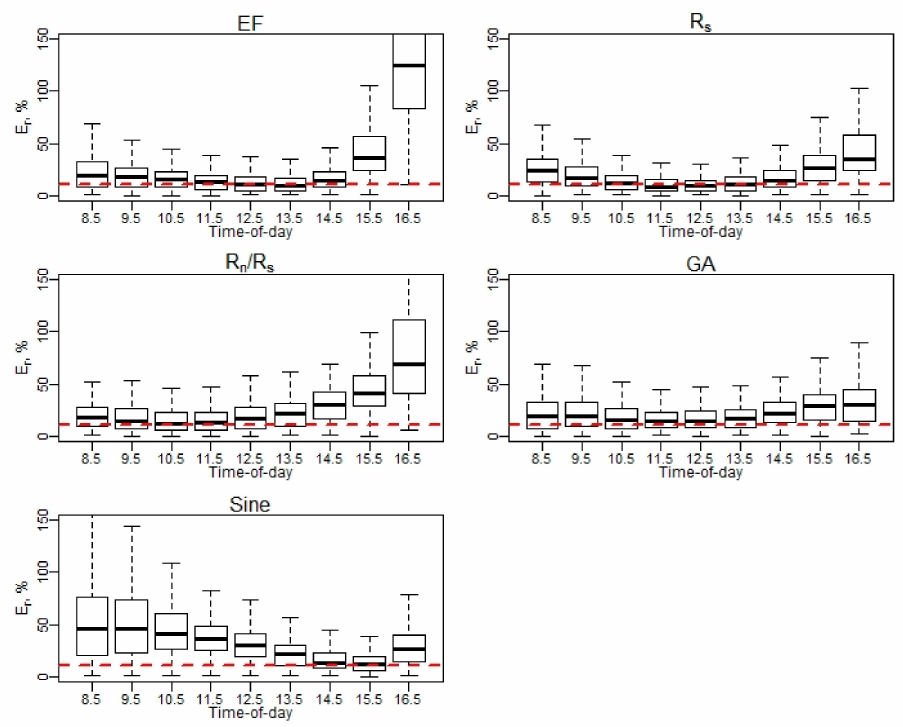
Figure A3. E r of daily EC ET (September–October). Note: Red dash line represents a 10% relative error ( E r ).